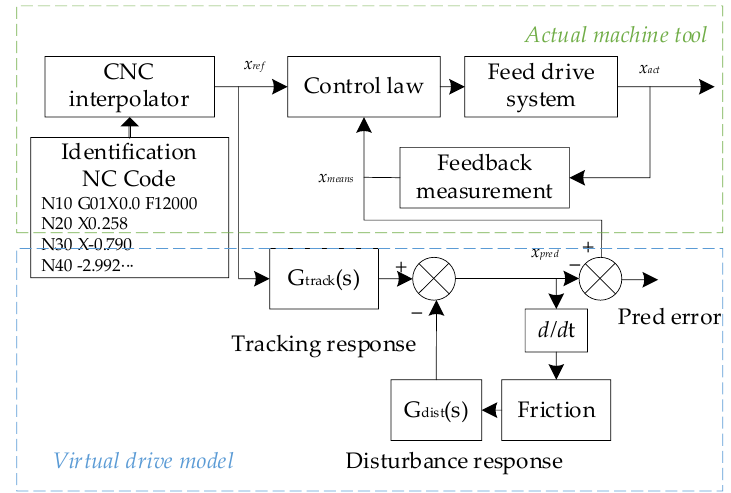
Figure 7. Overview of rapid identification scheme [53].